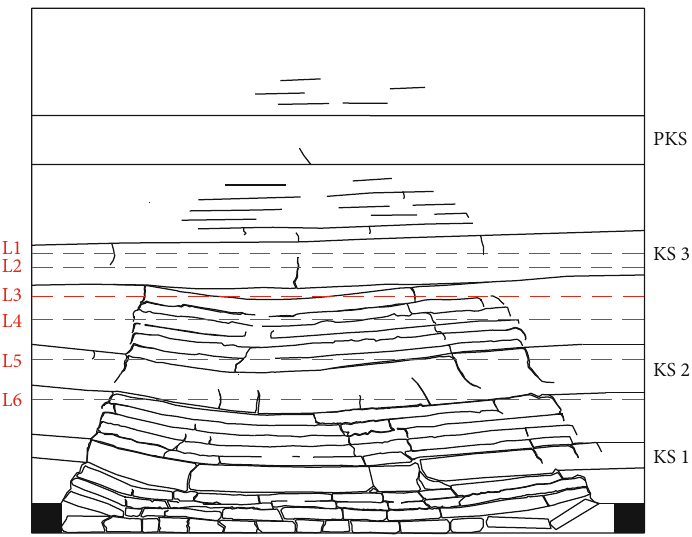
Figure 5: Sketched simulation results of the overburden